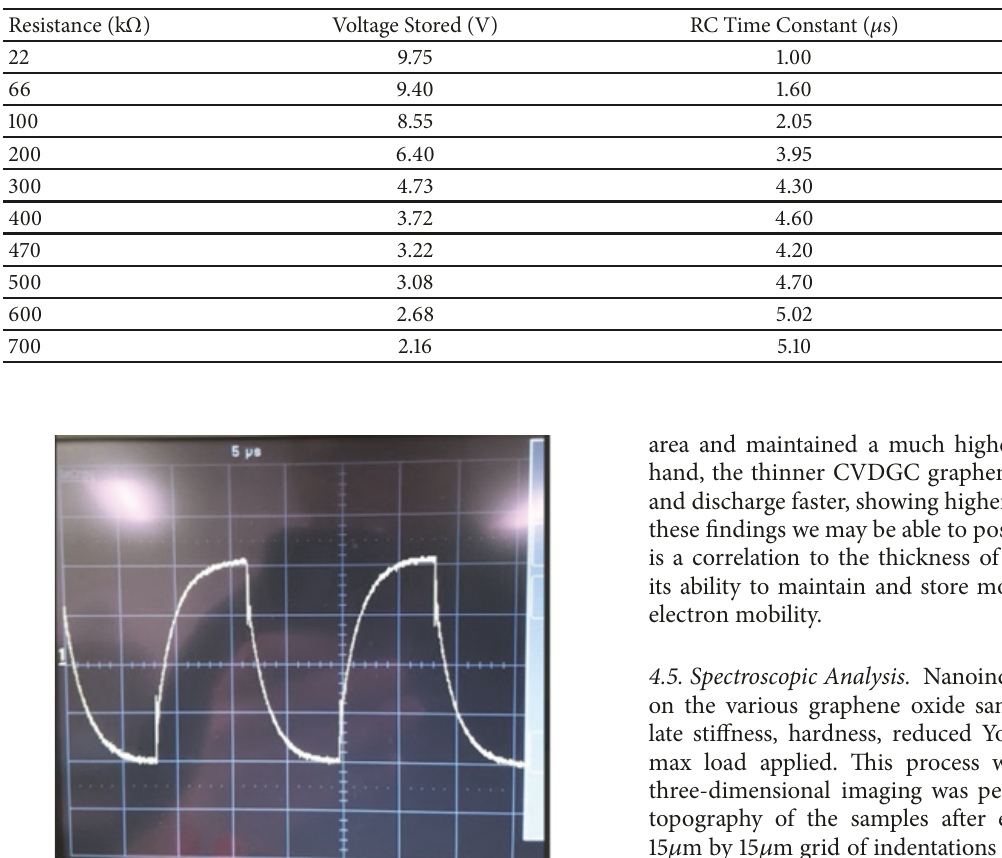
Figure 14: FTIR spectrum of homemade graphene oxide after one, two, and five oxygen reduction cycle. Table 2: Data for the commercially purchased CVD graphene capacitor.